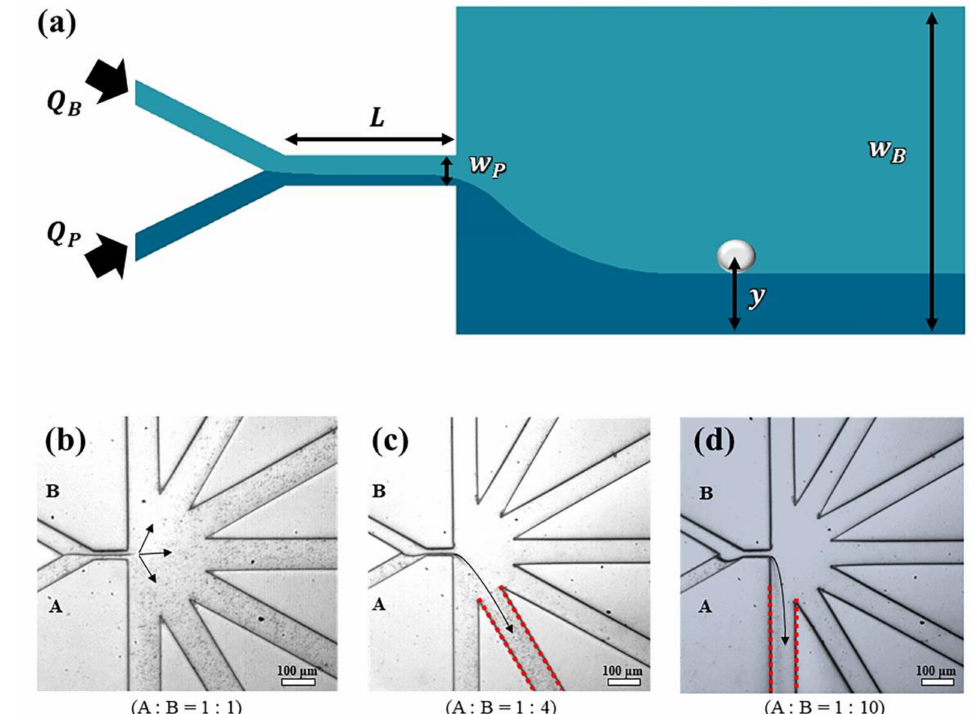
Figure 3. ( a ) A schematic of the pinched flow fractionation microchannel with a particle. Trajectory of 10 µ m of hollow glass particles in di ff erent flow rate ratios of ( b ) 1:1, ( c ) 1:4, and ( d ) 1:10 ( µ L /